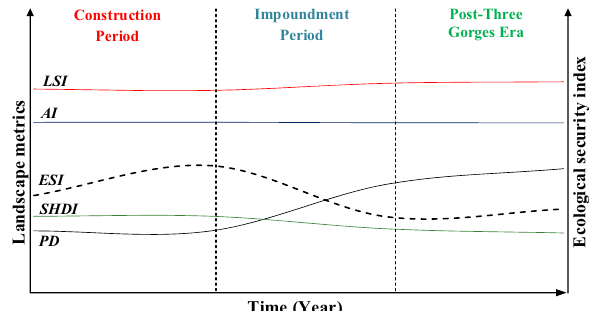
Figure 12. Change in landscape pattern indexes in the